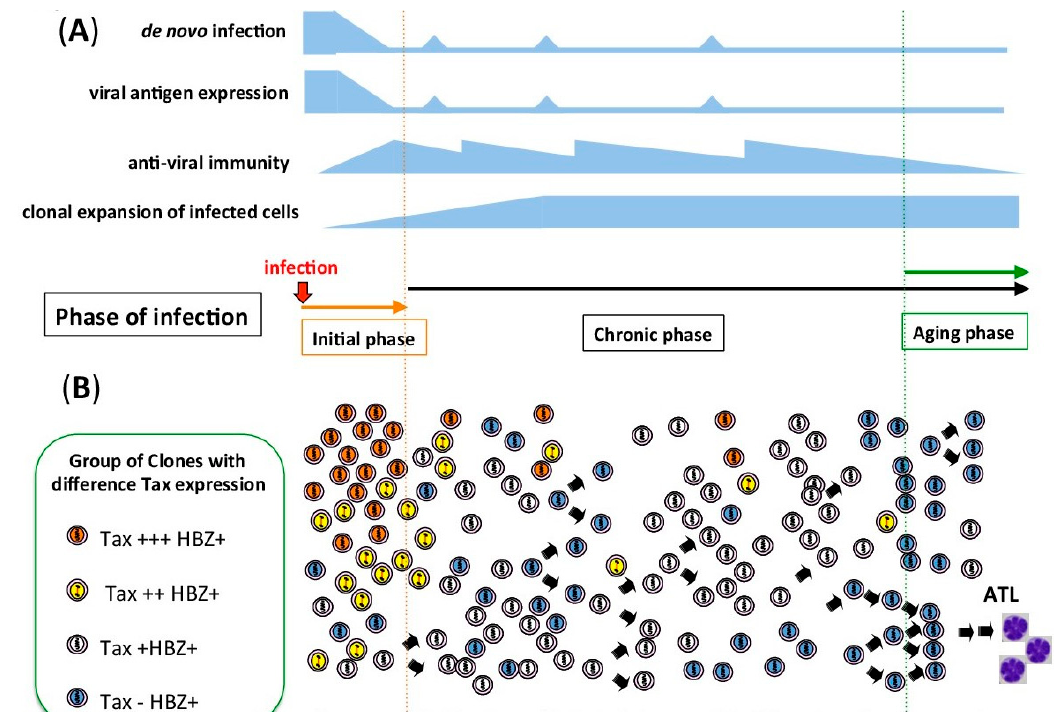
Figure 1. Schematic figure of Human T ‐ cell leukemia virus type 1 (HTLV ‐ 1) infection from the